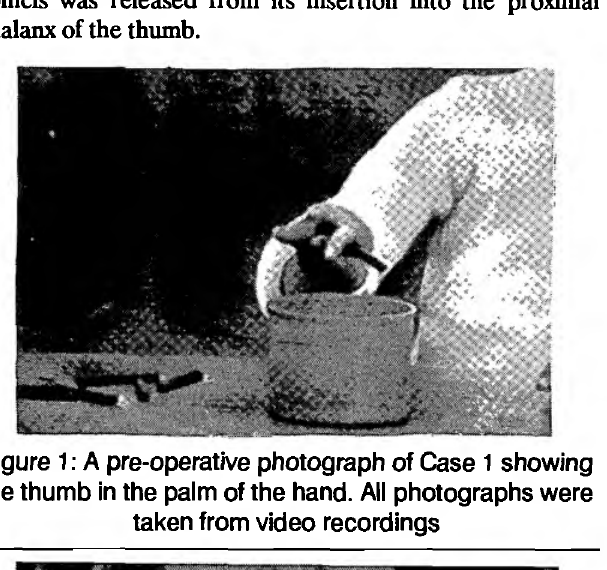
Figure 1: A pre-operative photograph of Case 1 showing the thumb in the palm of the hand. All photographs were taken from video recordings